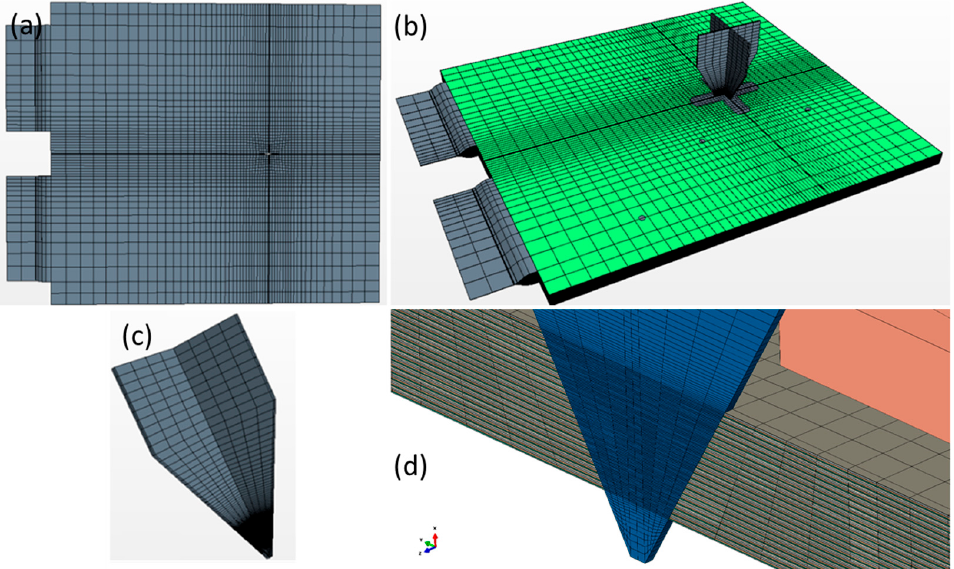
Figure 3. Overview of the mesh utilized for the calculation. ( a ) Top view of the cell, whereby the mesh has finer seeds near the point of nail puncture; ( b ) overview of the cell and the nail in its final position; ( c ) the nail was meshed in order to obtain coincident nodes at the contact surface; therefore, the elements density is higher on the portion of the nail that is in contact with the cell; and ( d ) section view of the nail introduced into the cell volume.